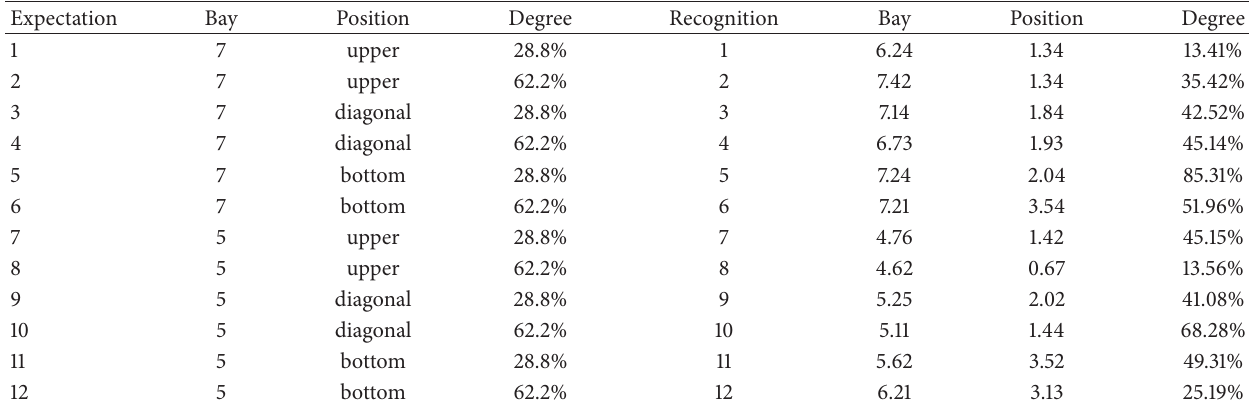
Table 14: Damage identification by using attribute set 2.